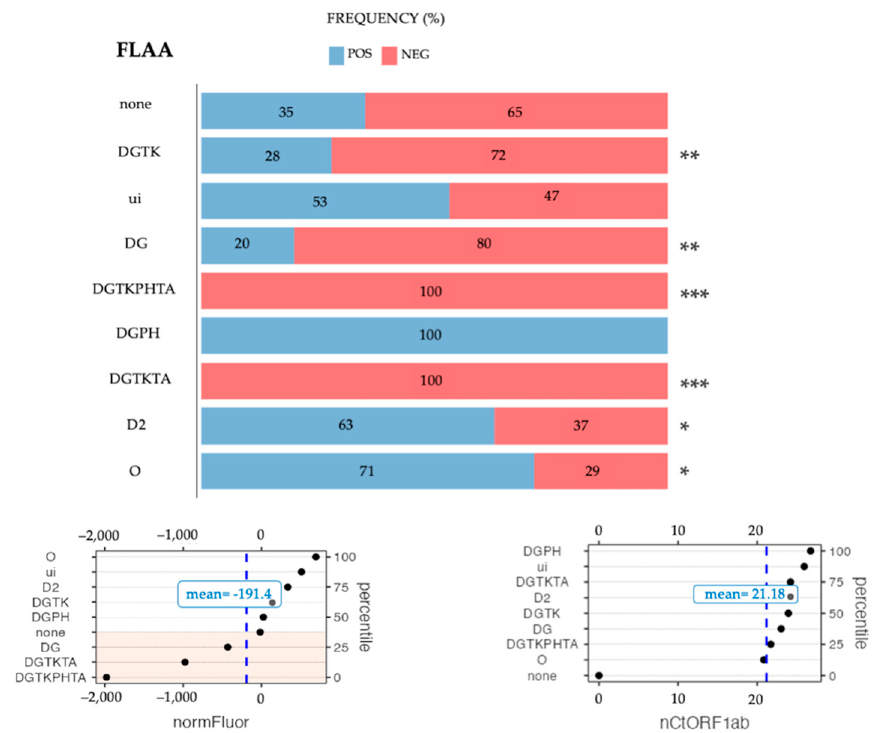
Figure 9. Frequency plot and dot-plots for means of normalized fluorescence and CtOrf1ab.